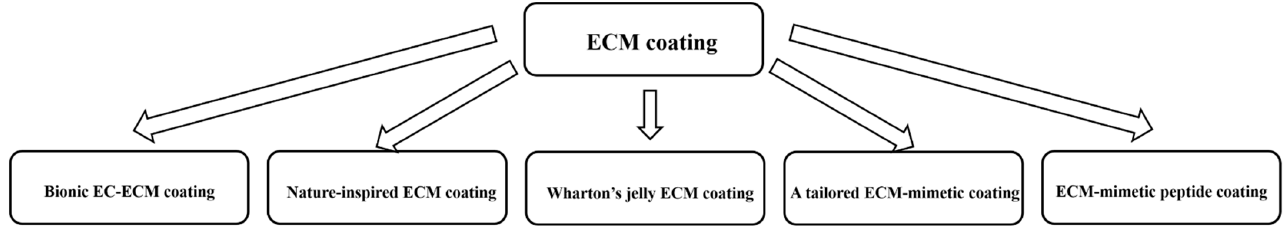
Figure 3. The classification of the types of ECM